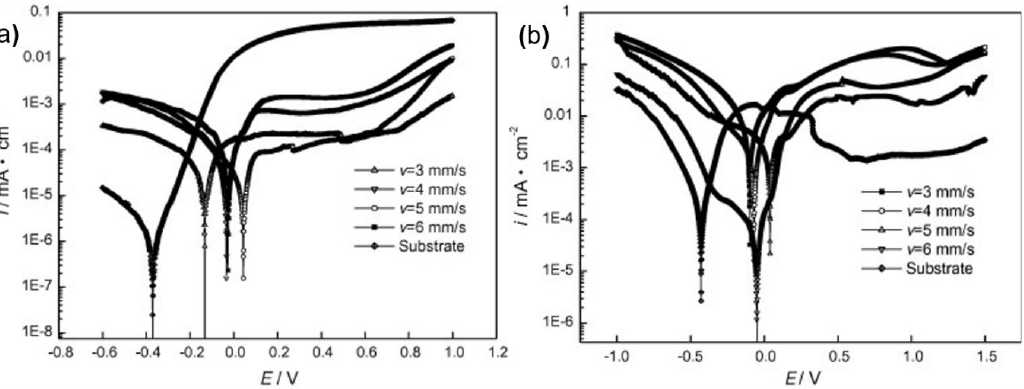
Figure 4. Potentiodynamic polarization curves for AlCrFeCoCu high-entropy alloys [ 55 ] . ( a ) In 1 mol/L NaCl solution. ( b ) In 0.5 mol/L H 2 SO 4 solution. Copyright 2013 Elsevier.